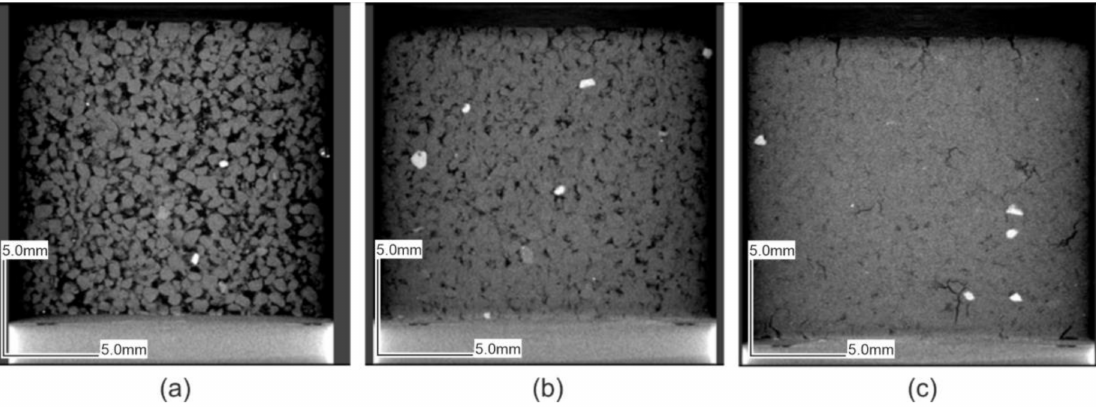
Figure 2. µ CT images of 10X specimens compacted to dry densities of ( a ) 1.4 g/cm 3 ; ( b ) 1.6 g/cm 3 ; ( c ) 1.8 g/cm 3